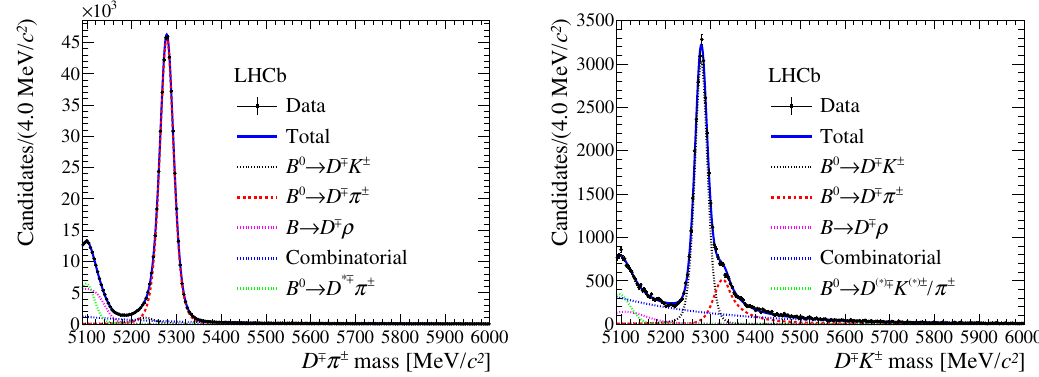
Figure 1 . Invariant mass distributions of the (left) pion-like and (right) kaon-like samples with (cid:12)t projections overlaid. The simultaneous (cid:12)t of the two distributions is described in the text and yields a (cid:31) 2 per degree of freedom of 1.18. The B ! D (cid:7) (cid:26) component includes both B 0 ! D (cid:7) (cid:26) (cid:6) and B (cid:7) ! D (cid:7) (cid:26) 0 decays. suppress to a negligible level cross-feed backgrounds such as (cid:3) 0